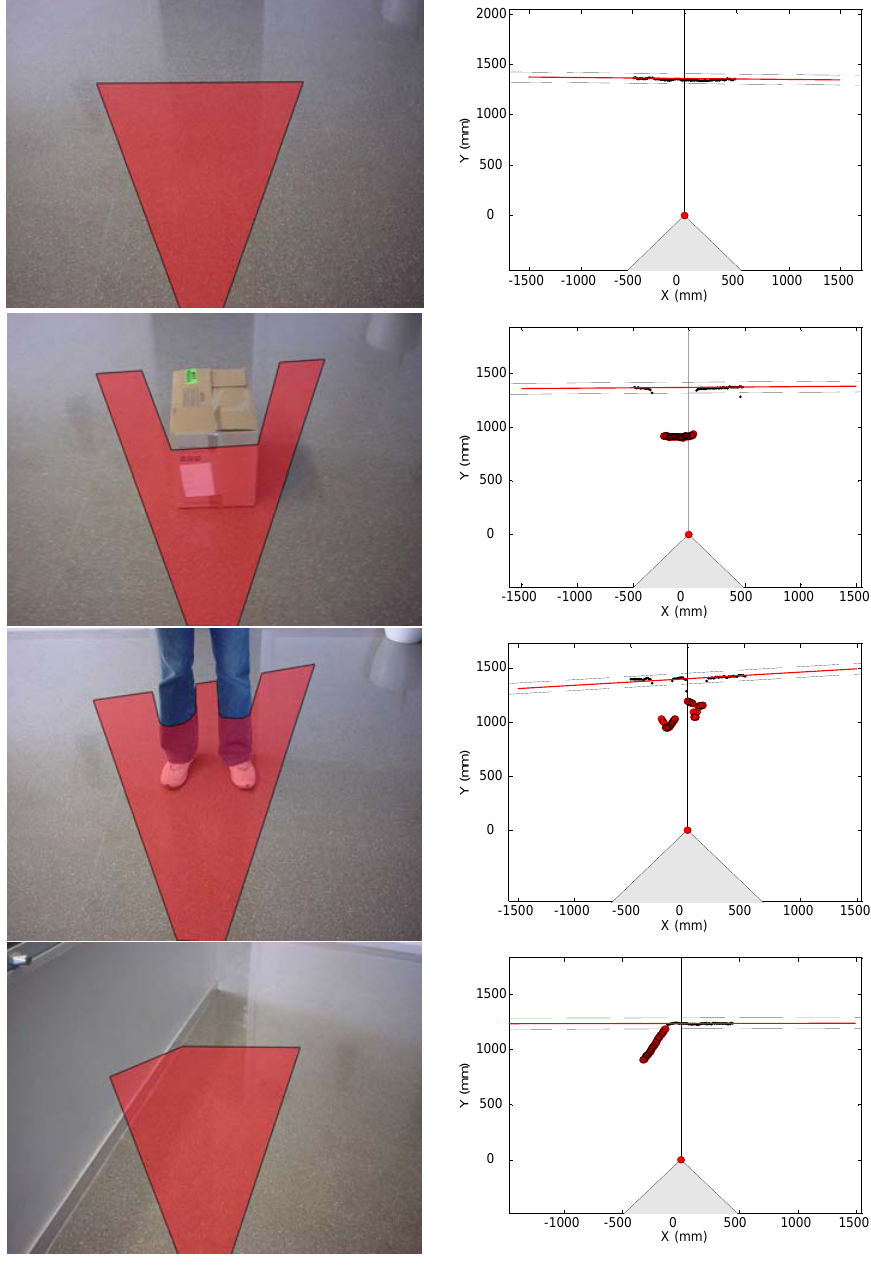
Table 2. Images of four events (left) and its detection through the analysis of the frontal line